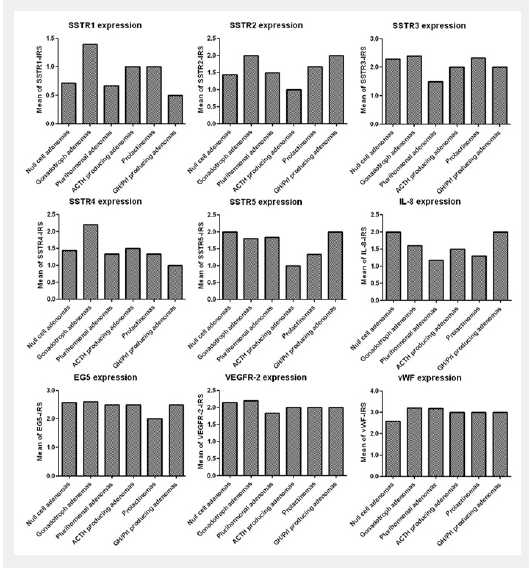
Figure 4 SSTR-, IL8-, Eg5-, VEGFR-2- and vWF-expression of the different pituitary adenoma subtypes. Note that the y-axes represent the mean immunoreactivity score. ACTH = adrenocorticotrophic hormone; Eg5 = kinesin spindle protein; GH = growth hormone; IL-8 = interleukin-8; Prl = prolactin; SSTR = somatostatin receptor; VEGFR-2 = vascular endothelial growth facto receptorr-2; vWF = von